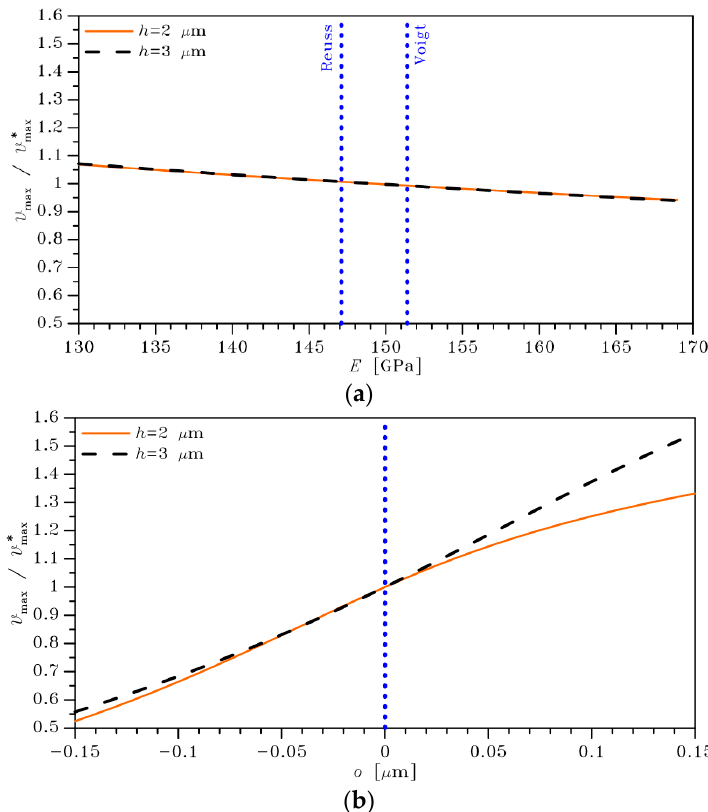
Figure 4. Sensitivity analysis: dependence of V max ( a ) on the polysilicon e ff ective Young’s modulus E , and ( b ) on the over-etch depth o